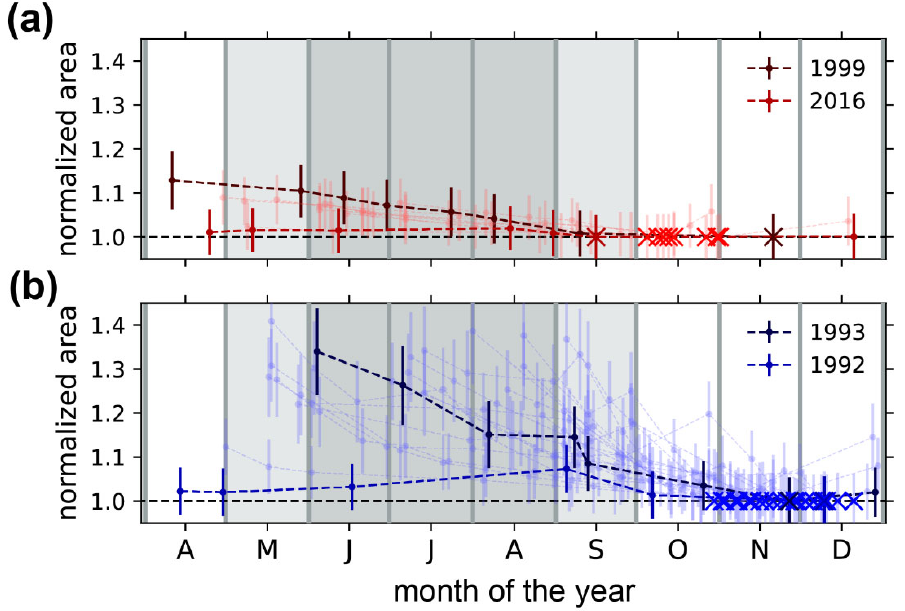
Figure 4. Variability in the area classified as snow and ice depending on which scene during the year is analyzed for ( a ) the Quelccaya Ice Cap and ( b ) Nevado Coropuna. The areas have been normalized to the scene with the minimum area for that year. Xs along the horizontal dashed line indicate the date each year of the scene with the minimum area. The 2- σ uncertainty intervals are indicated by the error bars. The light gray shaded region notes the nominal dry season (May through September) for the outer tropics, and the darker gray shaded region notes austral winter (June, July, August).